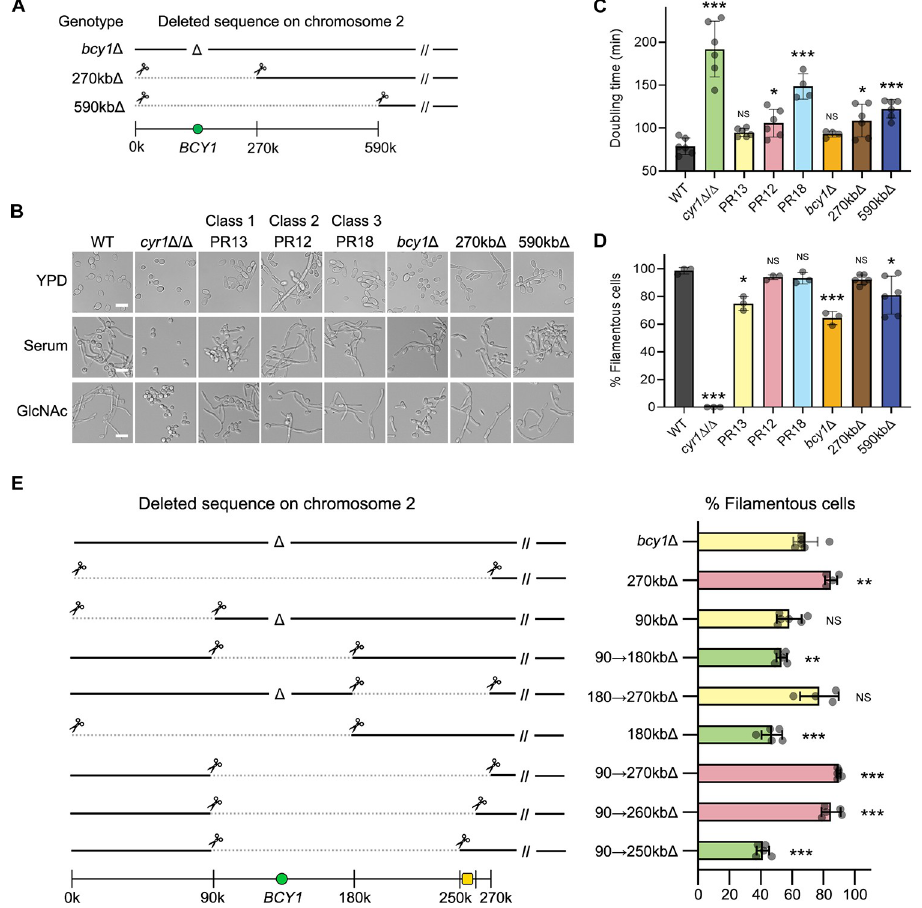
Fig 2. Gene mapping by CRISPR-Cas9 demonstrates that haploinsufficiency of genes in chromosome 2 improved hyphal induction in cyr1 Δ / Δ PR mutants. (A) A schematic diagram showing deleted sequences on chromosome 2. (B) The strains indicated at the top were grown in the liquid medium indicated on the left, and then hyphal induction was assessed microscopically. Cells were grown in liquid medium containing 15% serum or 50 mM GlcNAc to induce hyphal growth at 37˚C for 3 h and then photographed. Scale bar, 10 μ m. (C) Doubling times were measured in liquid YPD medium at 30˚C. Shown is the mean ± SD of 6 independent experiments. The doubling time of the strains shown was significantly shorter when compared to the cyr1 Δ / Δ background (p < 0.01). (D) Graph indicating the percent of filamentous cells after growth in GlcNAc medium described in panel B. Shown is the mean ± SD of at least 3 independent experiments with at least 100 cells counted for each condition. (E) Gene mapping by CRISPR-Cas9 identified a 10-kb region (yellow square) that is involved in the filamentous phenotype. The left panel shows deleted sequences on chromosome 2. The right panel shows the percent of filamentous cells in liquid GlcNAc medium at 37˚C; green, weak hyphal induction; yellow, intermediate hyphal induction; pink, strong hyphal induction. (A and E), Note that deletions are heterozygous; the cells retain a wild-type version of chromosome 2. Numbers and symbols indicate gene deletion ( Δ ), CRISPR cut site (scissors), large genomic deletion (dotted line), BCY1 gene (green circles), and chromosomal position (kb). (C and D) Statistical analysis was performed using one-way ANOVA with Dunnett’s multiple comparisons test comparing the strains with the WT or parental strain; NS p > 0.05, � p < 0.05, �� p < 0.01, ��� p <